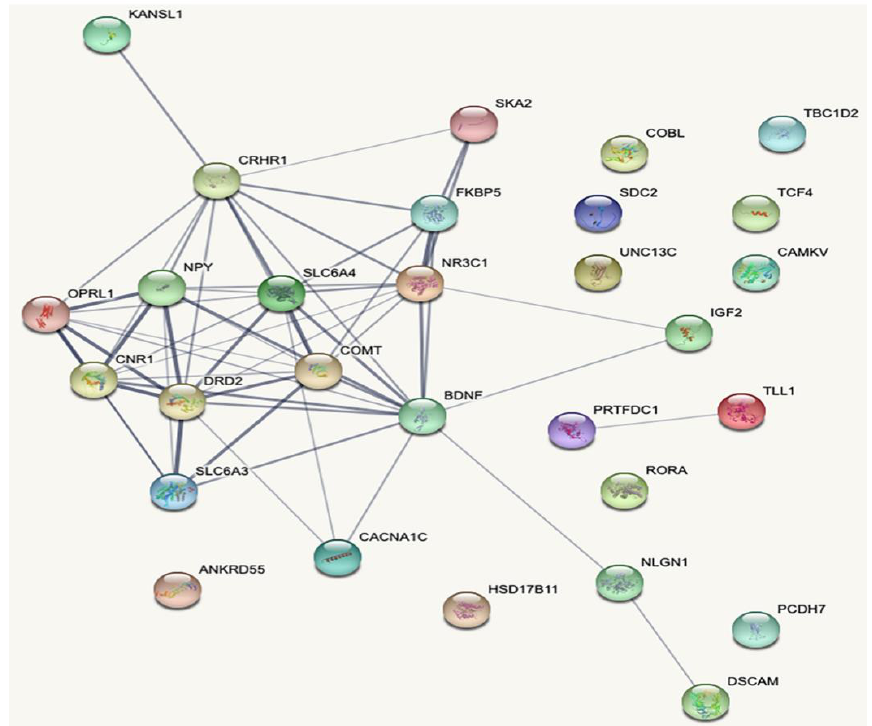
Figure 4. Gene interaction map for PTSD genes generated using string1 webserver. The thickness of the line indicates the strength of the interaction between the genes.